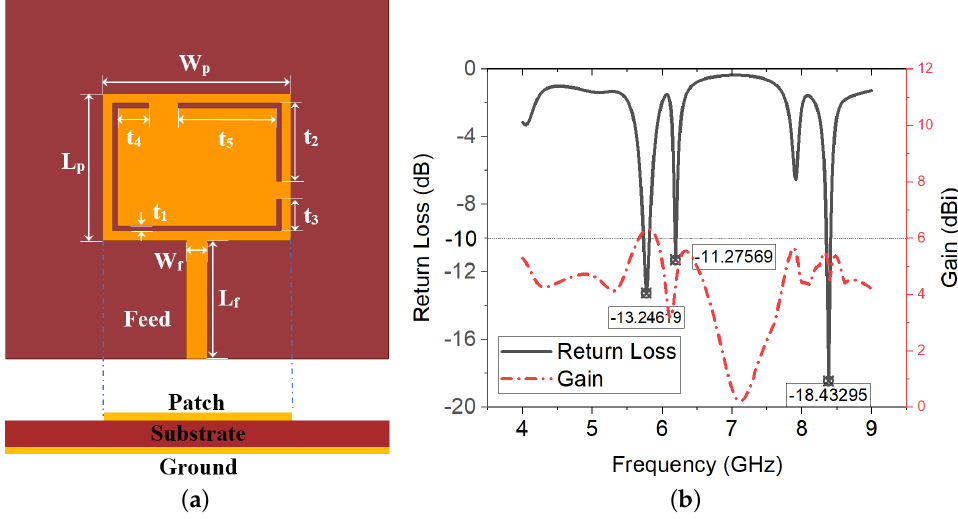
Figure 9. Finalised antenna layout and antenna performance. ( a ) Triband slot antenna structure layout. ( b ) Simulated return loss and gain of the proposed